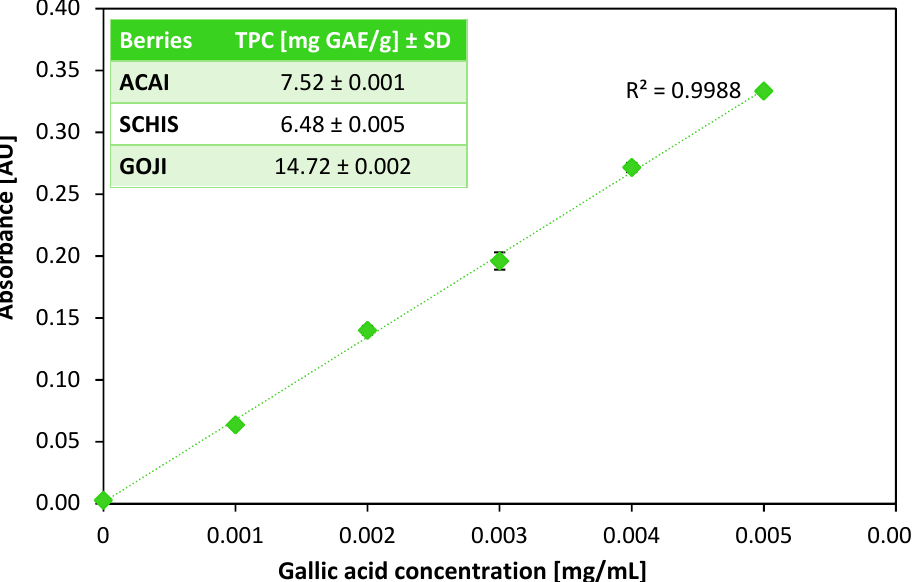
Figure 1. Calibration curve for gallic acid (GA). Absorbance was measured at λ 765 nm at 25 °C. Inset: values of total phenolic content in aqueous extracts from three tested berries species. (Data are expressed as mean ± standard deviation (n = 3)).